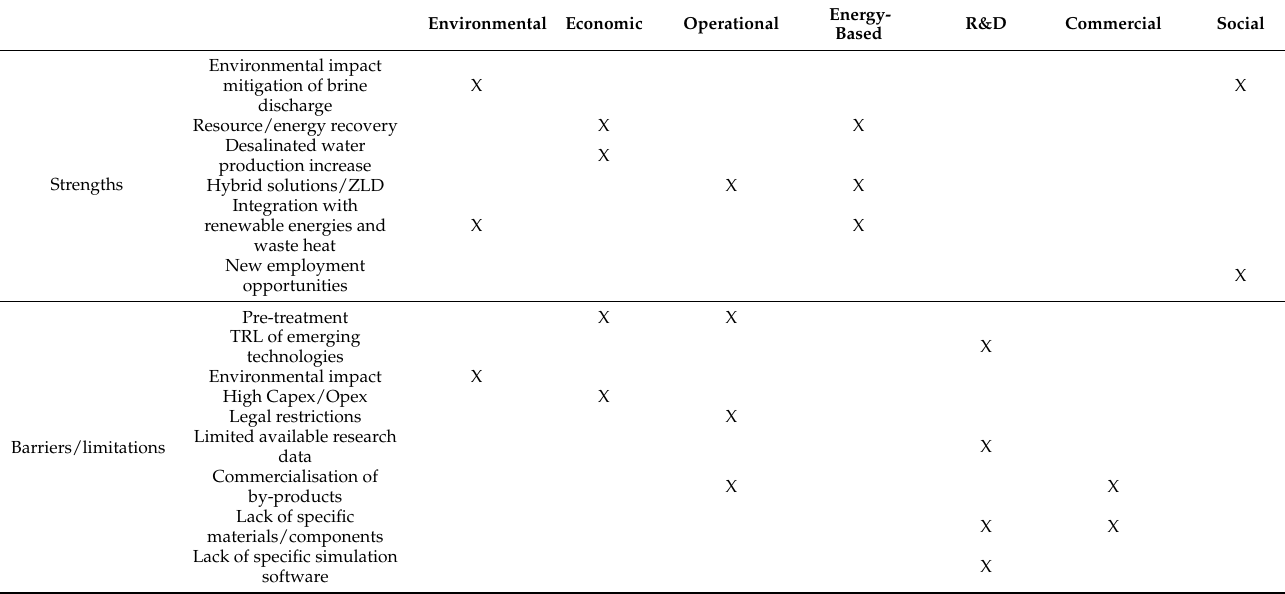
Table 3. Classification of factors for DBV industrialisation.